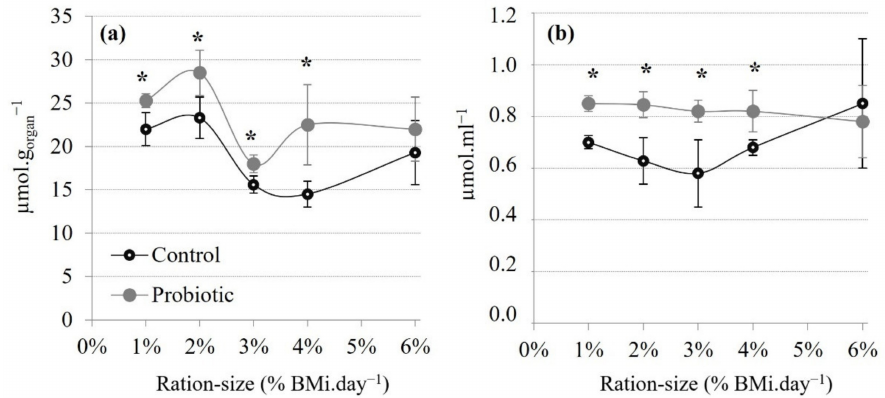
Figure 3. Total Antioxidant Status (TAS) in ( a ) the digestive gland and ( b ) haemolymph of shrimps from each treatment according to each ration size at the trial’s end-point. Mean ± SD, n = 3 with 4 shrimps/tank assessed. Asterisk indicate significant differences between diets at each ration size (2-way ANOVA, PLSD; * p <